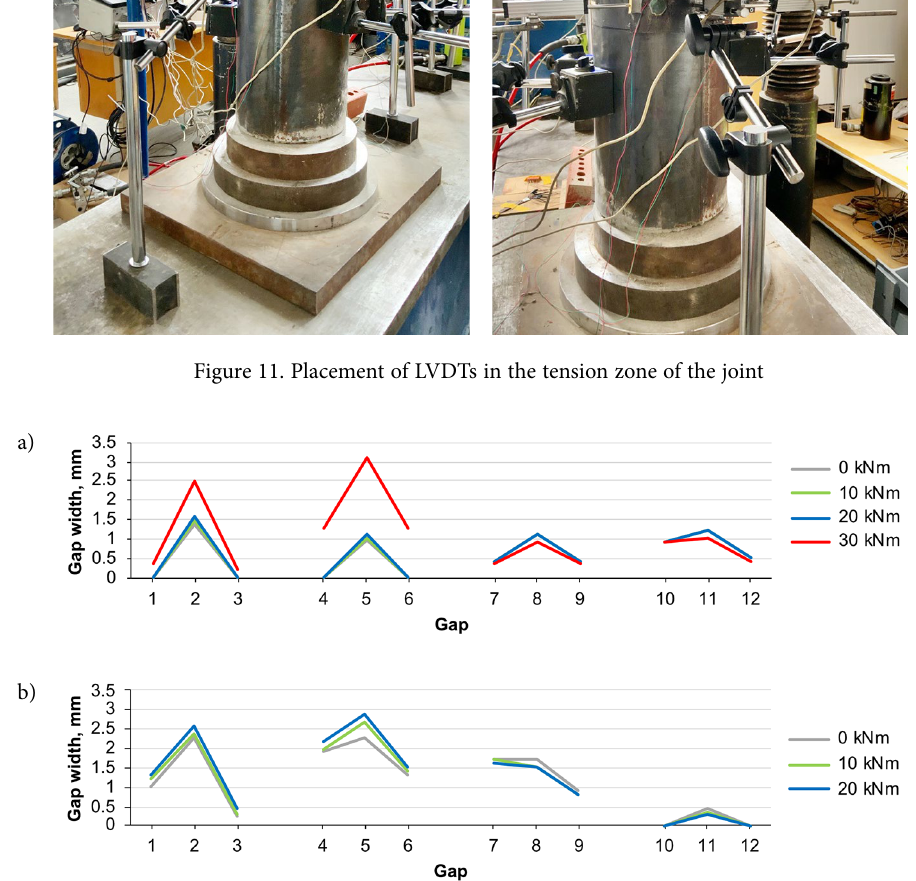
Figure 12. Gaps between the end-plate and the column (numbered according to Figure 10): a – connection 1B (preloaded bolts); b – connection 4B (snug tightened